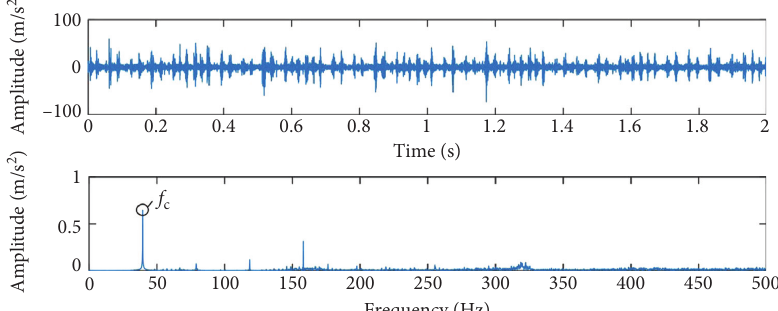
Figure 18: Original vibration signal.